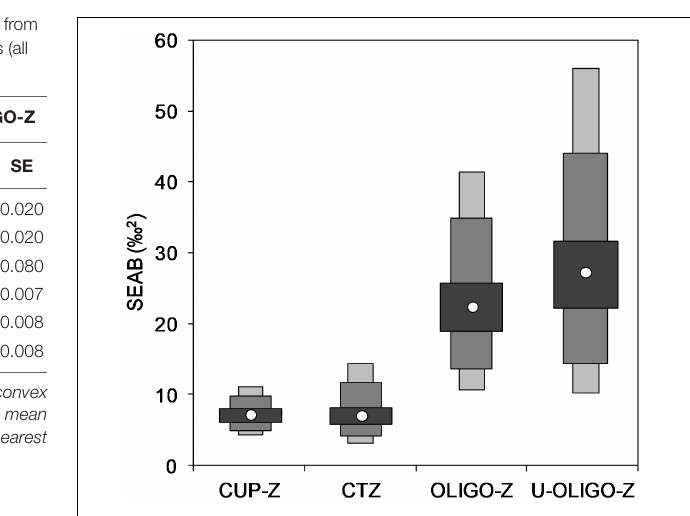
FIGURE 5 | The standard ellipse areas (SEAB) for the plankton communities considered in this study and computed from the Bayesian multivariate distributions fitted to the original isotope data for each zone (all size-classes combined). The modes (white dots) and the intervals encompassing 50, 95, and 99% of the estimations (shaded boxes) are